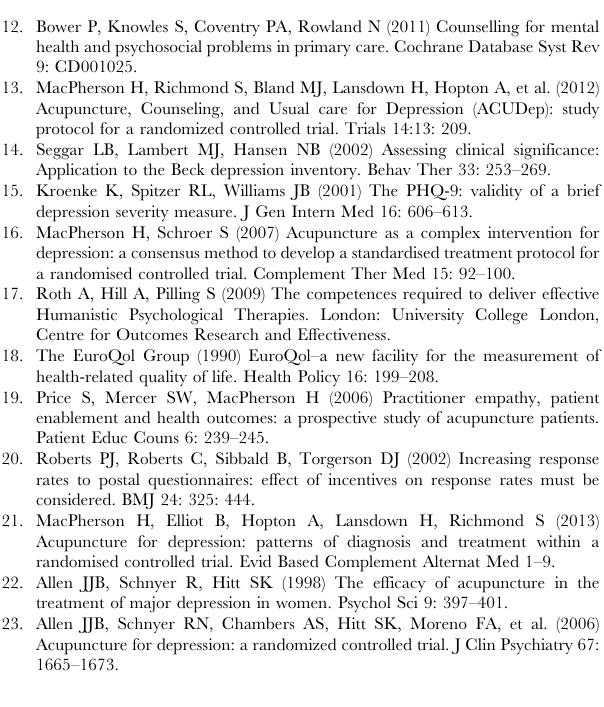
Table S6 Usual care provided: number of patients admitted to hospital and number of overnight stays in the preceding 3 months. Table S7 Usual care provided: number of patients paying for private health care & money spent in the preceding 3 months. Table S8 Effect of trial arm on PHQ-9 depression at 3 months and BDI-II depression at 12 months (non- imputed